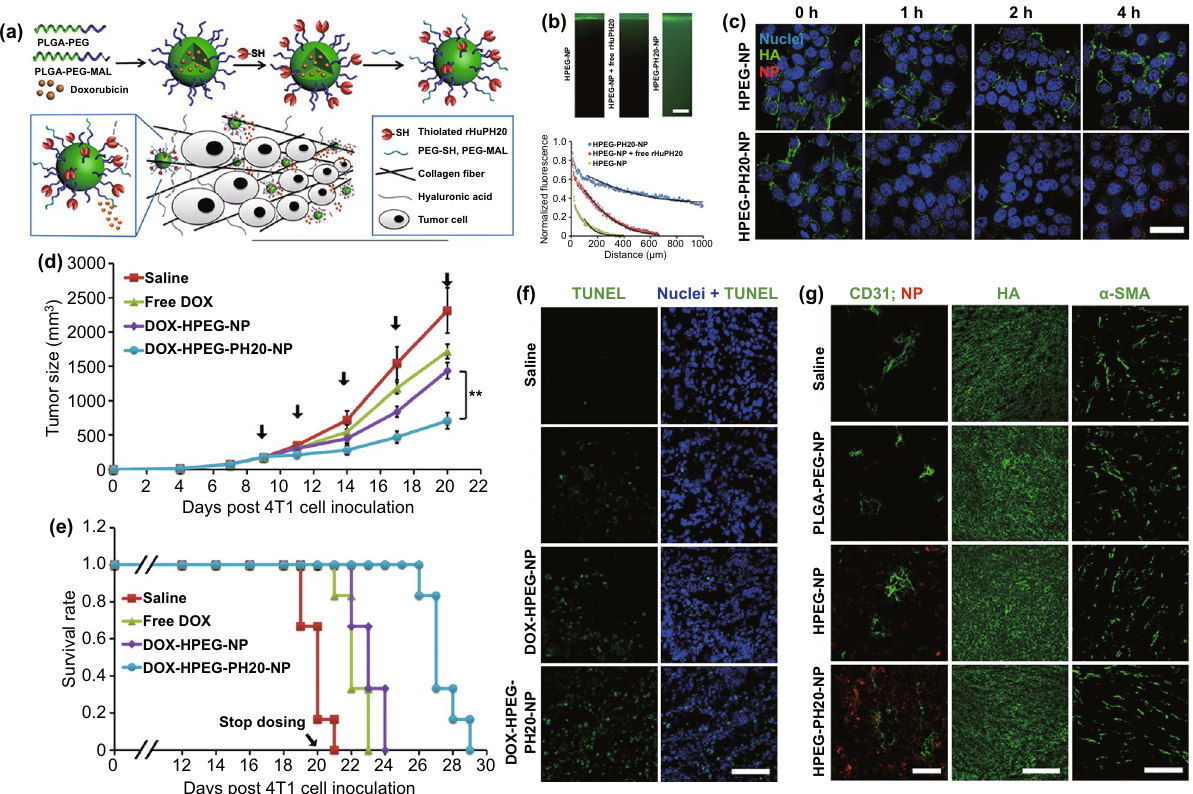
Fig. 8 a Schematic illustration of NP fabrication and penetration in tumors via the degradation of hyaluronic acid (HA). The NPs were fabri- cated by conjugating thiolated rHuPH20 on the first PEG layer followed by anchoring the second PEG layer. b NP diffusion in ECM-mimicking gels. (Scale bar: 200 μm). The gels composed of 6.5 mg mL −1 of rat collagen I and 1 mg/mL of HA in capillary tubes. Ten microliters of 1 mg mL −1 of NPs (green) were added on the top of gels and incubated at 37 °C for 1.5 h before being imaged. The activity of free or conjugated rHuPH20 was 500 U mL −1 and normalized NP fluorescence with diffusion distance in gels. Images were analyzed via ImageJ. Diffusion coef- ficients were obtained by fitting the data to a one-dimensional diffusion model in MATLAB. Black lines display theoretical intensity profiles for particles with diffusion coefficients of 1.66 × 10 −7 , 7.17 × 10 −8 , and 1.11 × 10 −8 cm 2 s −1 . c Confocal microscopy images of 4T1 cells treated with 0.02 mg mL −1 of either HPEG-NPs or HPEG-PH20-NPs with enzyme activity of 10 U mL −1 for 0, 1, 2, and 4 h. HA, nuclei, and DiD-labeled NPs were shown in green, blue, and red, respectively. The signal included both internalized particles and particles bound on cell surfaces (Scale bar: 50 μm). d In vivo tumor growth inhibition curves for 4T1 tumor-bearing mice that were treated with either saline, free DOX, DOX-HPEG- NPs or DOX-HPEG-PH20-NPs. The dose of DOX was 2 mg kg −1 for free DOX and DOX-encapsulated NPs. Values indicate mean ± SD (n = 6). **P < 0.01. Black arrows indicate the time of injection. e Survival rate plots show the percentage of animals remained alive in the study. Mice were sacrificed and were no longer counted for survival rate when their tumor size exceeded 2000 mm 3 . **P < 0.01. f TUNEL staining of sec- tioned tumor tissues that were collected after the completion of all doses for the groups treated with saline, free DOX, DOX-HPEG-NPs, and DOX-HPEG-PH20-NPs. Green, TUNEL; blue, nuclei. Scale bar: 100 μm. g Staining of sectioned tumor trusses that were collected 24 h post the administration of saline or NPs. The mice were iv injected with saline or DiD-labeled NPs on day 9 post 4T1 cell inoculation. Left column showed the staining of CD31 (green, representing blood vessels) and the distribution of NPs (red). The middle column showed the HA staining and the right column showed the α-SMA staining for the four study groups. Scale bar: 50 μm (left); 200 μm (middle); 100 μm (right). Repro- duced with permission from Ref.